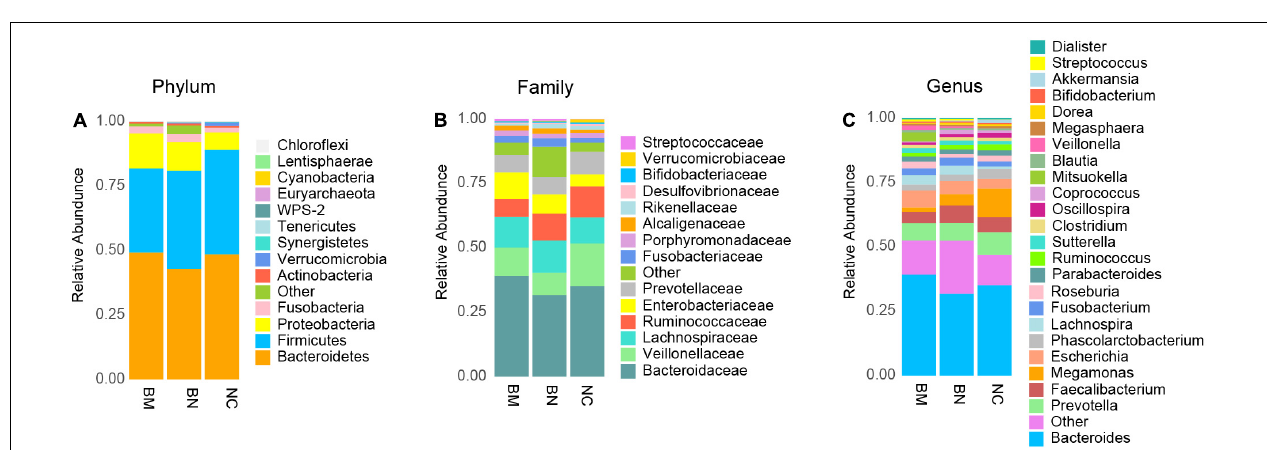
FIGURE 2 | Analyses of the gut microbiota community profiles. (A) Box plots comparing the beta diversity of NCs, BNs, and BMs. (B) PLS-DA of the distinct gut microbiota community profiles of NCs, BNs, and BMs.